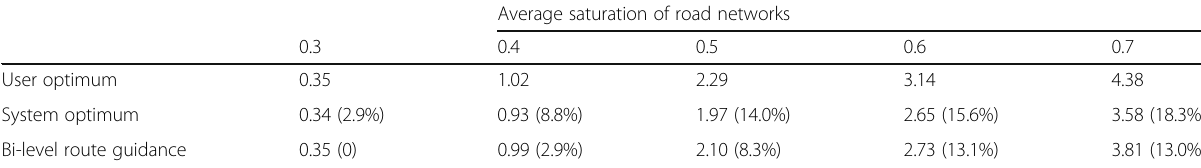
Average saturation of road